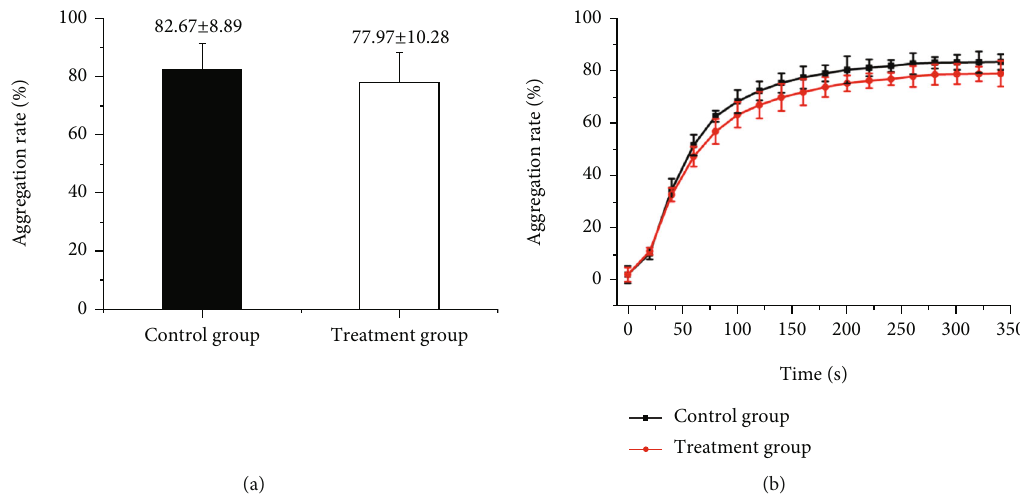
Figure 2: Comparison of aggregation rate between the treatment group and control group. (a) Comparison of aggregation rate between the treatment group ( n = 30 ) and control group ( n = 30 ). The aggregation rate of the treatment group was lower without any signi fi cant di ff erence to that of the control group (77.97 vs. 82.67%, P > 0 : 05 ). (b) Comparison of time point between the treatment group ( n = 30 ) and control group ( n = 30 ); aPRP reached the maximum aggregation rate. The time point of the treatment group and the control group was 240 and 260 s, respectively ( P > 0 : 05 ).